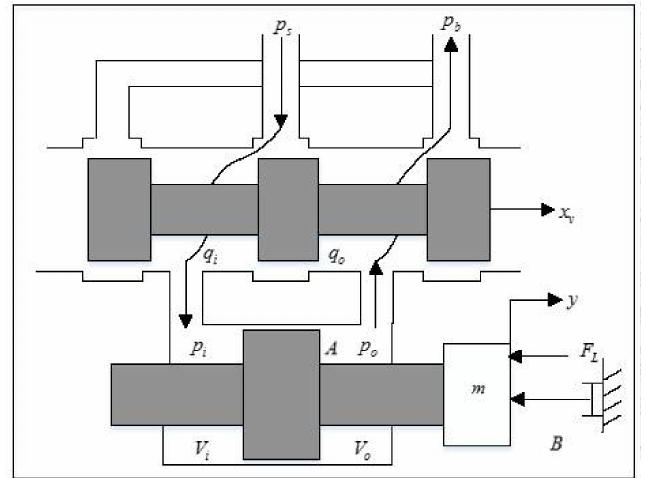
Figure 2. Schematic diagram of the hydraulic